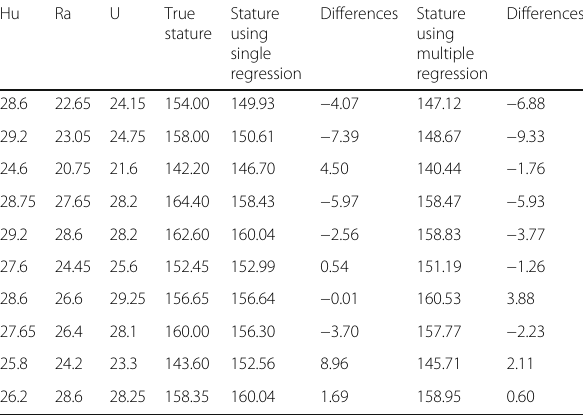
using linear regression and multiple regression